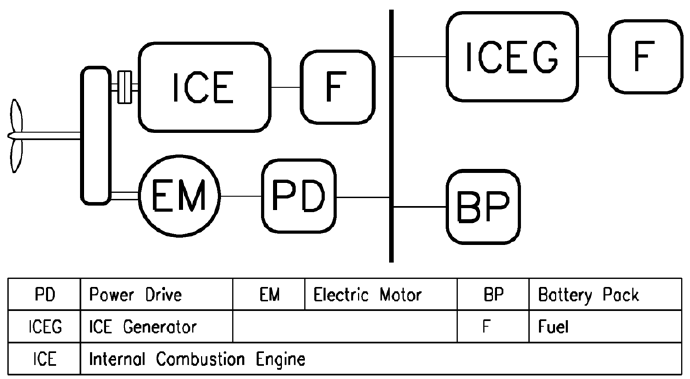
Figure 5. Electric propulsion, parallel configuration.